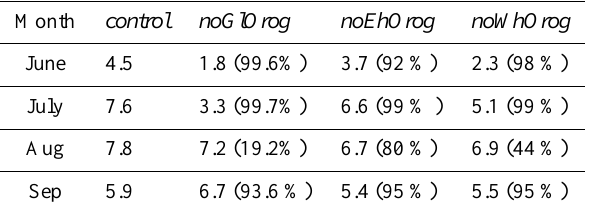
Table 2. Table showing the monthly mean precipitation in control , noGlOrog , noEhOrog and noWhOrog simulations. The values in parentheses indicates the significance level at which the perturbed simulations differ from control using a paired t-test.